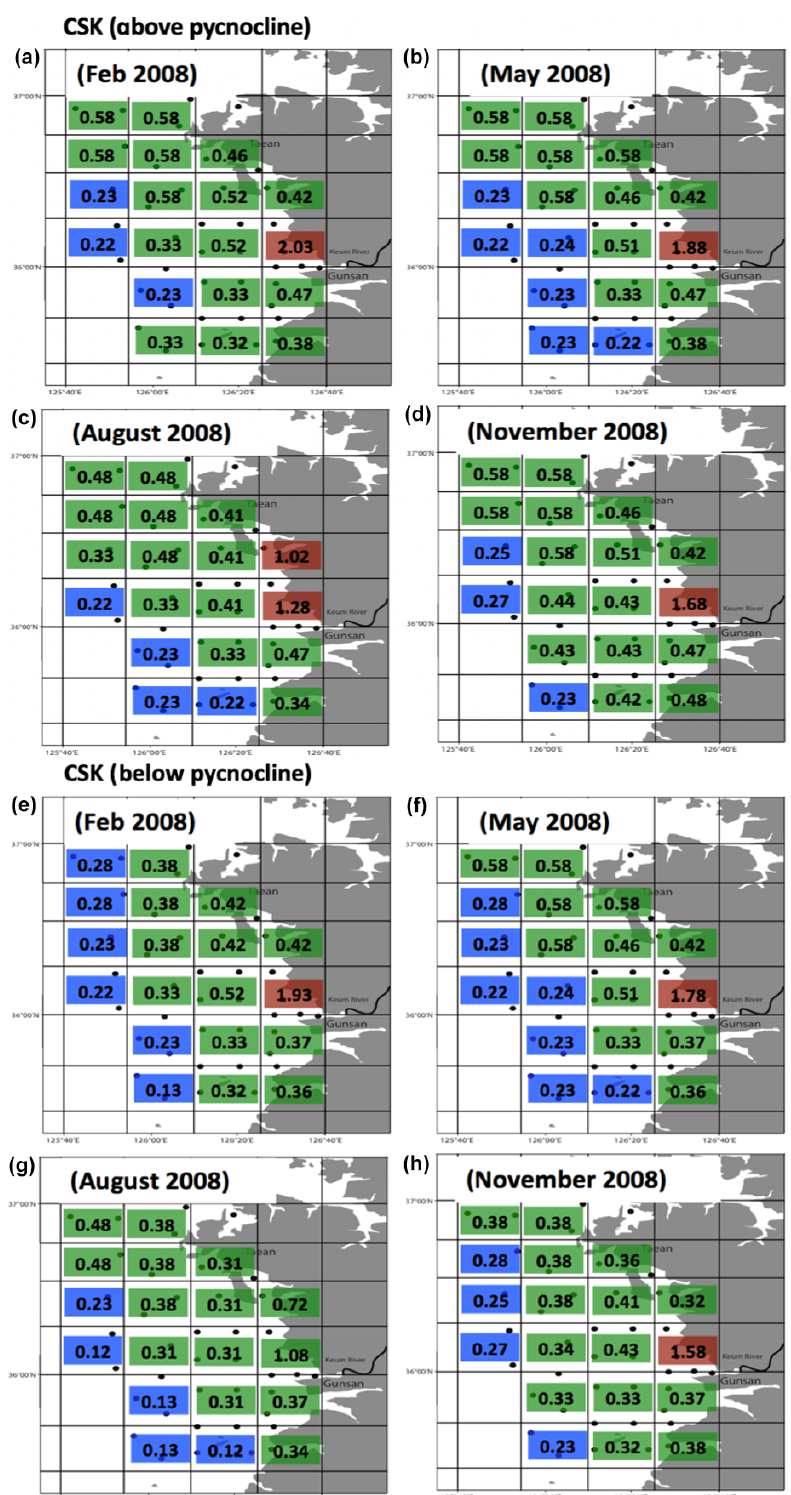
Figure 7. The distribution of the three zones of the mid-western CSK above the pycnocline (a–d) based on the RC02 hypothesis applied to the N mass balance model. Colors and numbers represent boxes found in each of the three zones in terms of potential productivity (unit: gCm − 2 d − 1 ). As for above, using data from below the pycnocline (e–h)